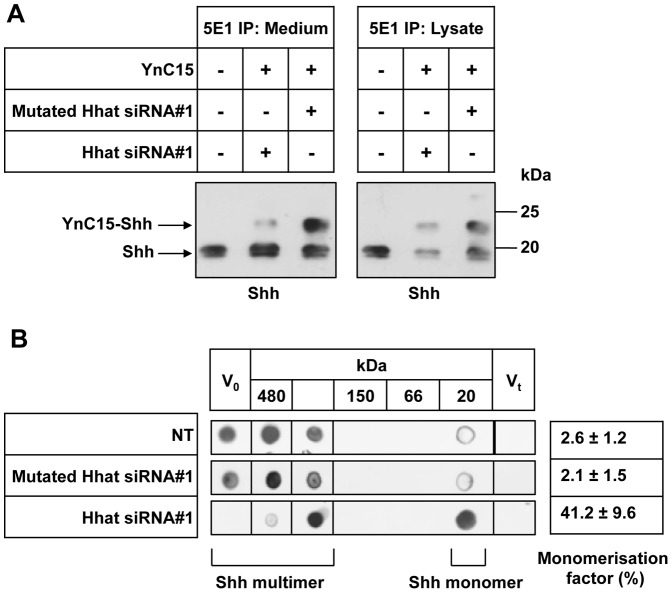
Hhat KD inhibits Shh palmitoylation and multimeric complex formation.A. 48 h after Hhat-#1 siRNA transfection PANC1 cells were labeled with YnC15, then medium and cell lysates were collected for 5E1 immunoprecipitation, treated by click chemistry and analyzed by Shh Western blot with H-160 Ab. In both medium and cell lysates, YnC15-labeled Shh was reduced in Hhat-#1 KD cells compared to Mutated Hhat-#1 and control cells. In contrast, YnC15-unlabeled Shh was more abundant in the medium of Hhat-#1 KD cells, but less abundant in cell lysates, demonstrating increased release when Hhat is knocked down. B. To examine the role of Hhat in Shh oligomerization, 72 h after siRNA transfection of PANC1 cells the media were subjected to gel filtration chromatography (Superdex200 10/300 GL column). After TCA precipitation, the fractions were probed by dot blot with anti-Shh H-160 antibody. Untreated and control Mutated Hhat-#1-treated cells showed an abundance of large complexes migrating near the void volume (Vo), whereas Hhat-#1 siRNA-treated KD cells had a much higher proportion of monomer (Vt represents the total volume of the column). Experiments were repeated three times with similar results.